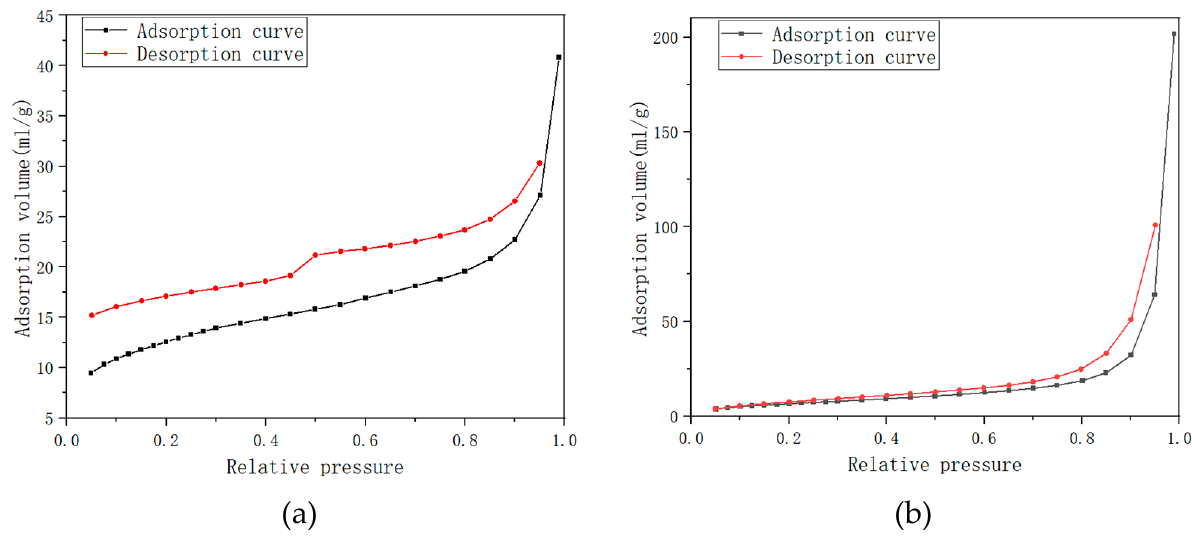
Figure 3. BET spectrum of ( a ) biochar and ( b ) biochar/polypyrrole.